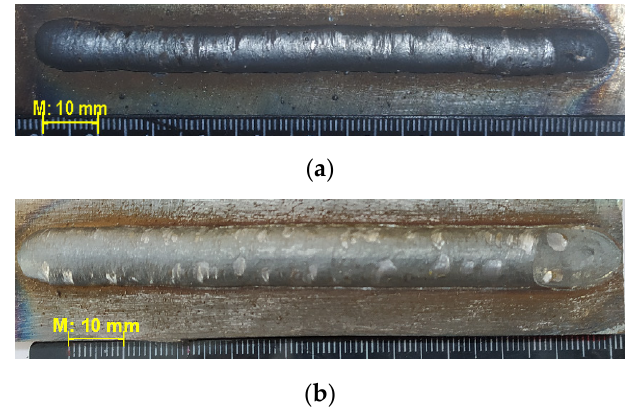
Figure 5. Single beads: ( a )—straight polarity, average width 7.97 ± 0. 16 mm; ( b )—reversed, average width 11 ± 0.3 mm.